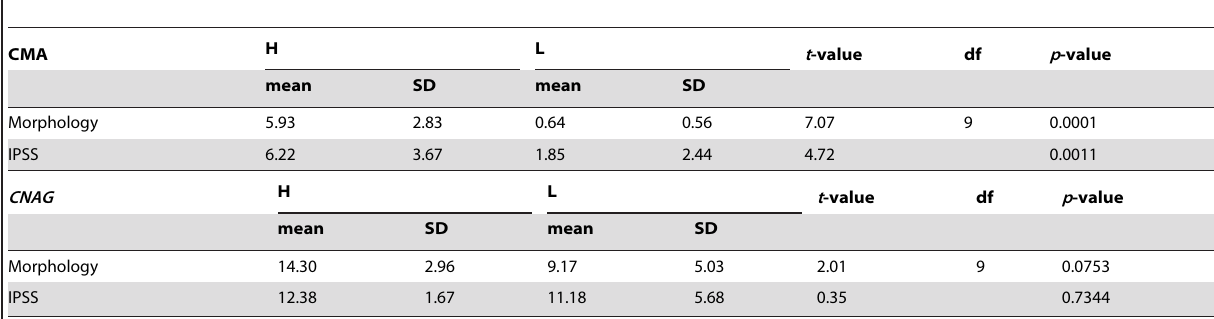
Table 7. Copy number aberrations comparison of CMA algorithm and CNAG (MDS-7 is excluded).